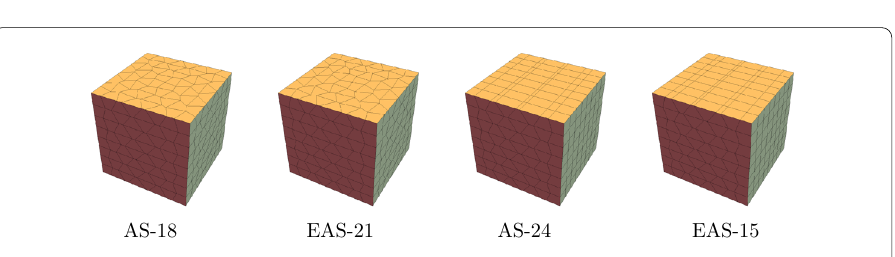
Fig. 14 Hourglassing test: development of the smallest eigenvalue of the stiffness matrix over the